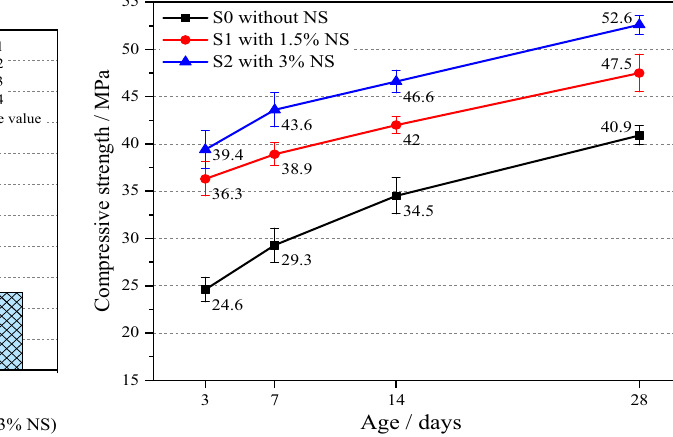
Figure 6: Mortar fl uidity test results. Figure 7: Development of compressive